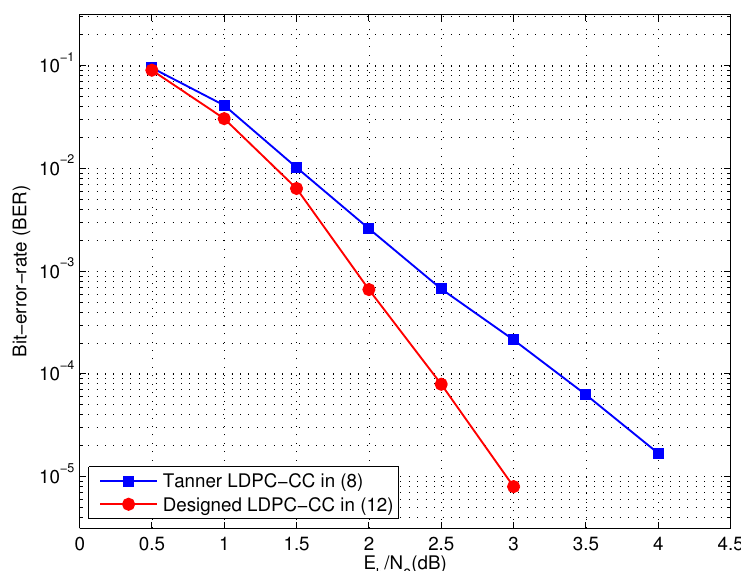
Figure 1. Decoding performance of the codes defined in Equations (12) and (8)